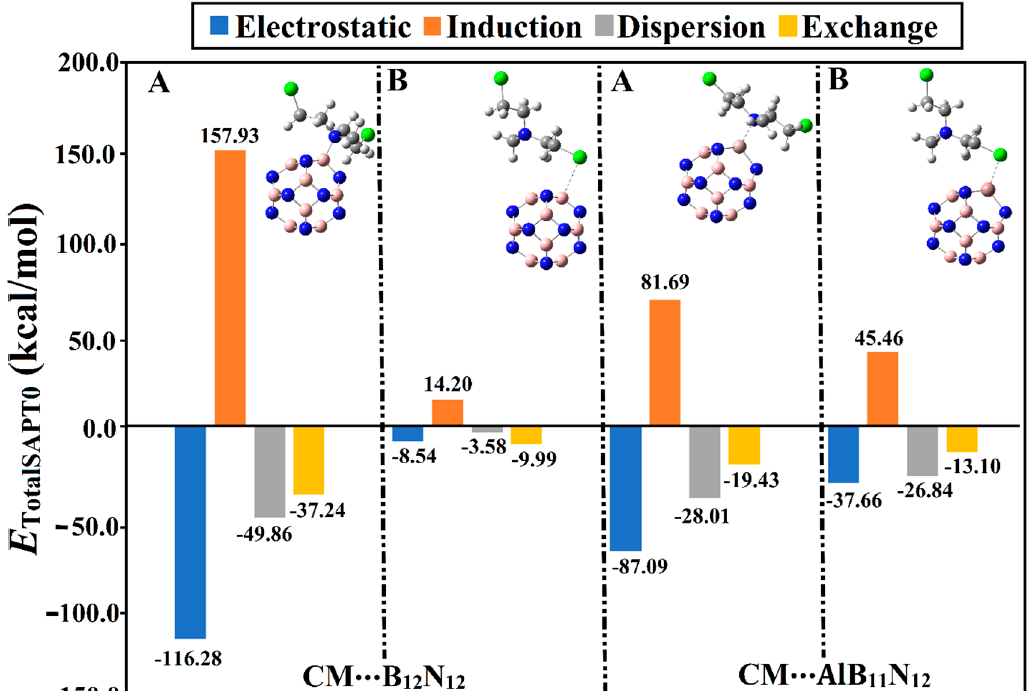
Figure 4. Bar chart presenting the physical components (i.e., electrostatic ( E elst ), induction ( E ind ), dis- persion ( E disp ), and exchange ( E exch )) of the total SAPT0 energies for the CM ∙∙∙ B 12 N 12 and ∙∙∙ AlB 11 N 12 optimized complexes in configurations A and B.